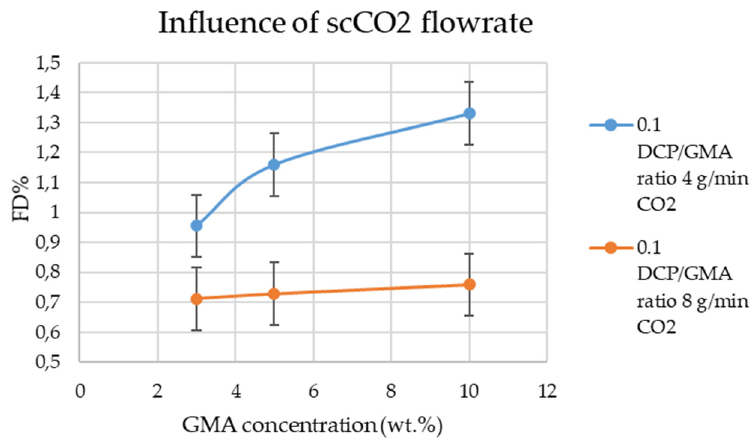
Figure 9. Influence in the scCO 2 flow.